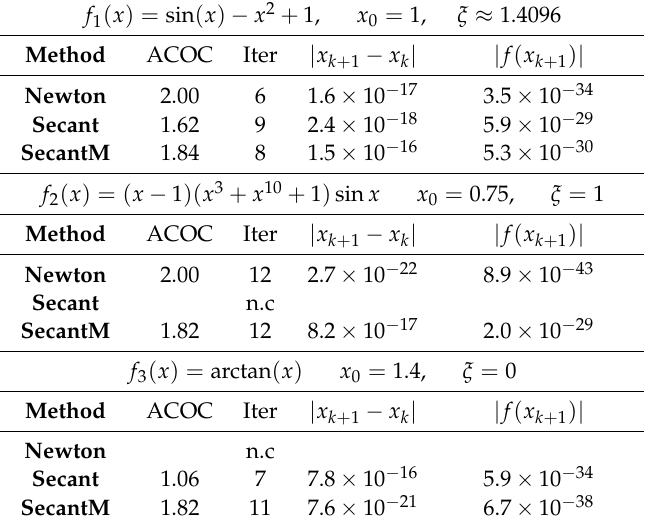
Table 1. Numerical results for the scalar functions f 1 ( x ) , f 2 ( x ) , f 3 ( x ) .